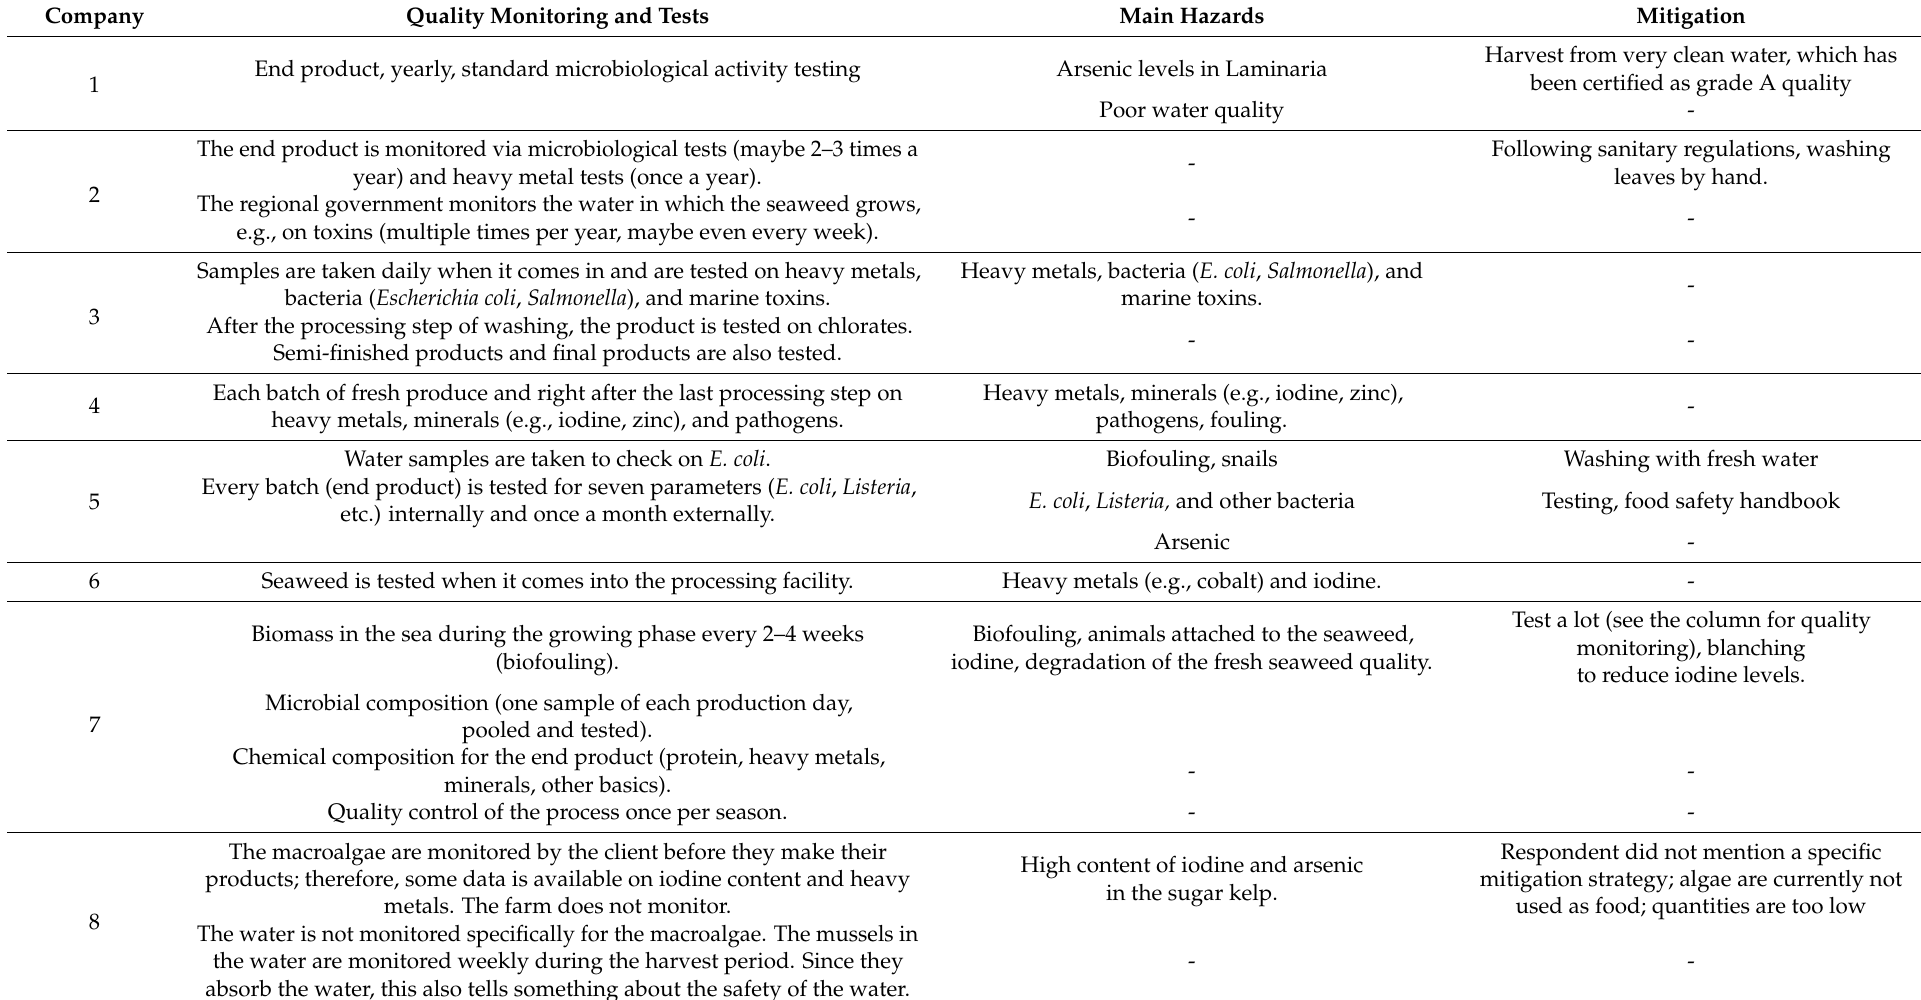
Table 3. Food safety hazards, the monitoring thereof, and measures to mitigate, as indicated by